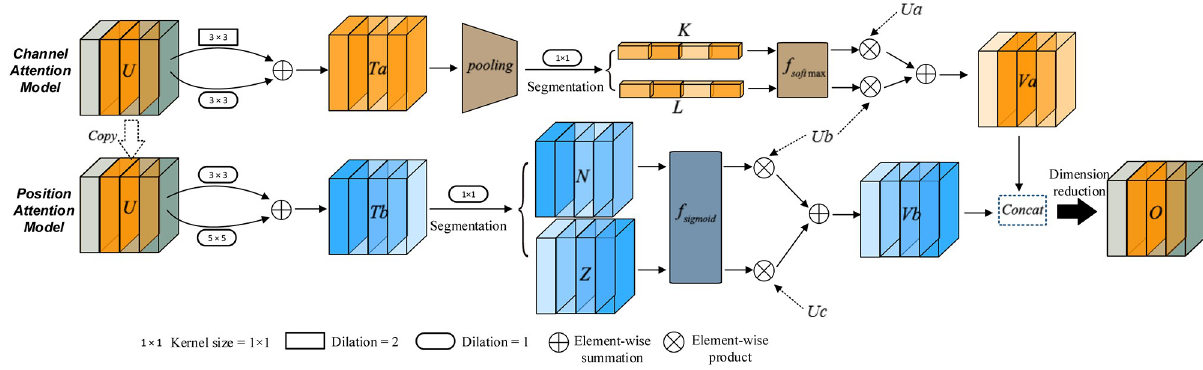
Fig 2. Overview of the proposed structure Multi-branch hybrid attention